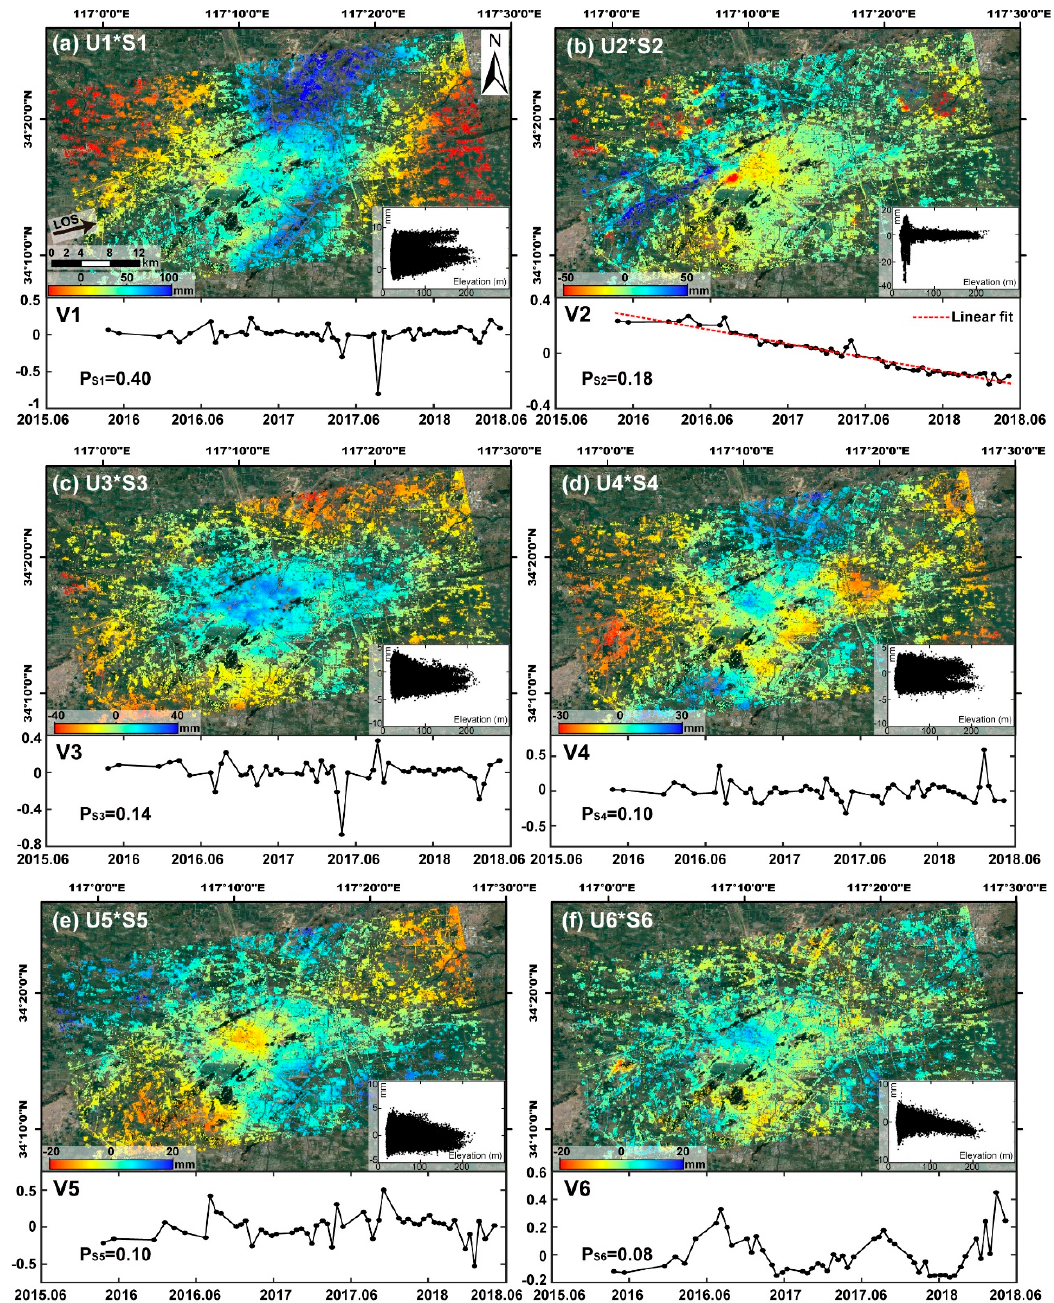
Figure 4. Results from the principal component (PC) decomposition applied to the initial InSAR time series, including the spatial function weighted by significance value (U*S), temporal function (V) and proportion of significance value (Ps) for each PC (sub-figures ( a )–( f ) for PC1–PC6). The scatter plots indicate the correlations between the PCs and the elevation (see Section 2 in the Supplementary Materials for enlarged scatter plots). Maps are overlain draped on a Google Earth image and projected in geographic Lat/Lon referenced to the WGS-84 datum.